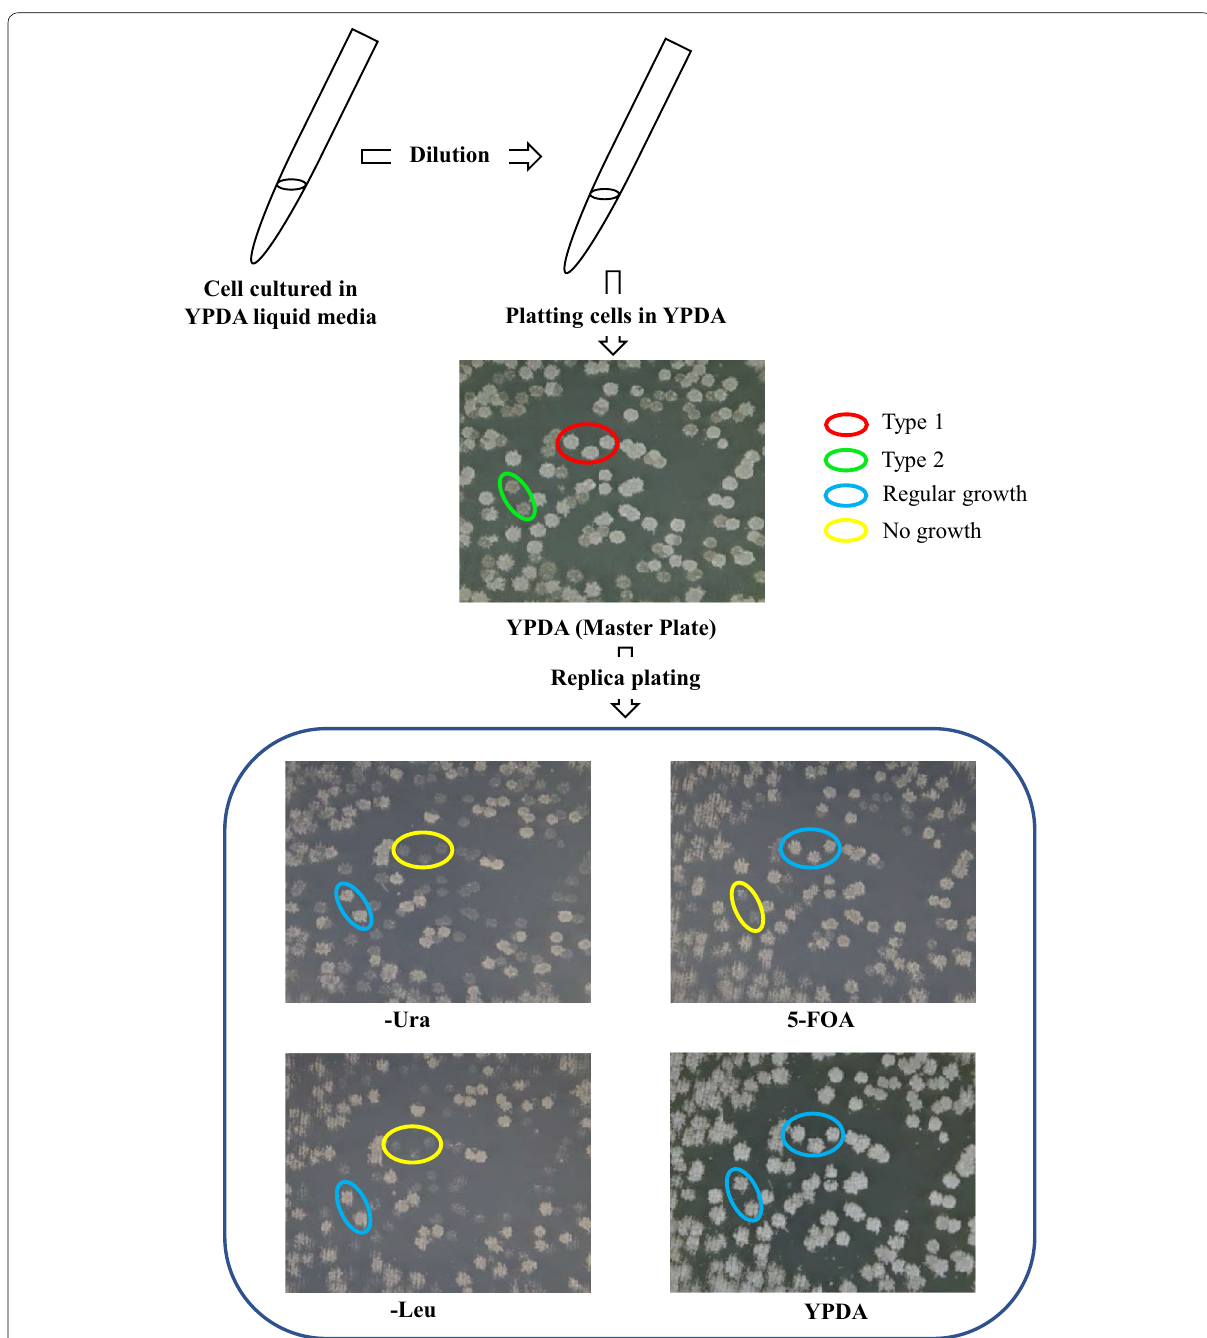
Fig. 5 Mini-chromosome loss assay. Transformants (constructed by splitting left and right edge of CgLEU2 replaced Chr2-6 region) harboring mini-chromosome consisting of only CgLEU2 and URA3 markers were cultured in liquid YPDA medium and subjected to dispense on YPDA plate after appropriate dilution. After colony formation, this plate was used as a master plate to replica plating on Ura minus, Leu minus, 5-FOA and YPDA media (as a control). After replica plating, two types of colonies were appeared in YPDA master plate, we named them as Type 1 and Type 2. To distinguish them, three Type 1 colonies were circled by red color and two Type 2 colonies were circled by green color. In other replica-plated plates, colonies that showed regular growth were circled by blue color and colonies that showed no growth were circled by yellow color. Type 1 colonies could not grow on Ura minus, Leu minus media but could grow on 5-FOA and YPDA media. On the other hand, Type 2 colonies could grow on Ura minus, Leu minus and YPDA media but could not grow on 5-FOA